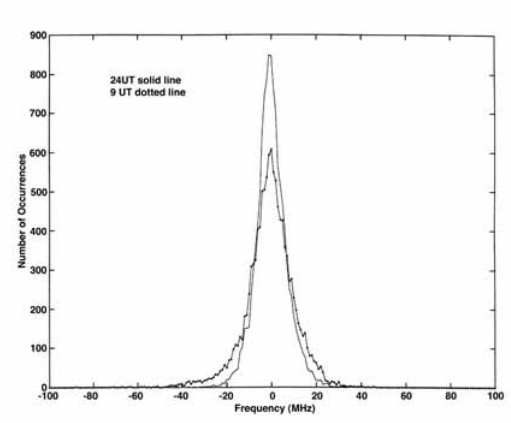
Fig. 5. Comparison of the histogram plots of the deviations from monthly medians for Rome at 24 UT and 9 UT.